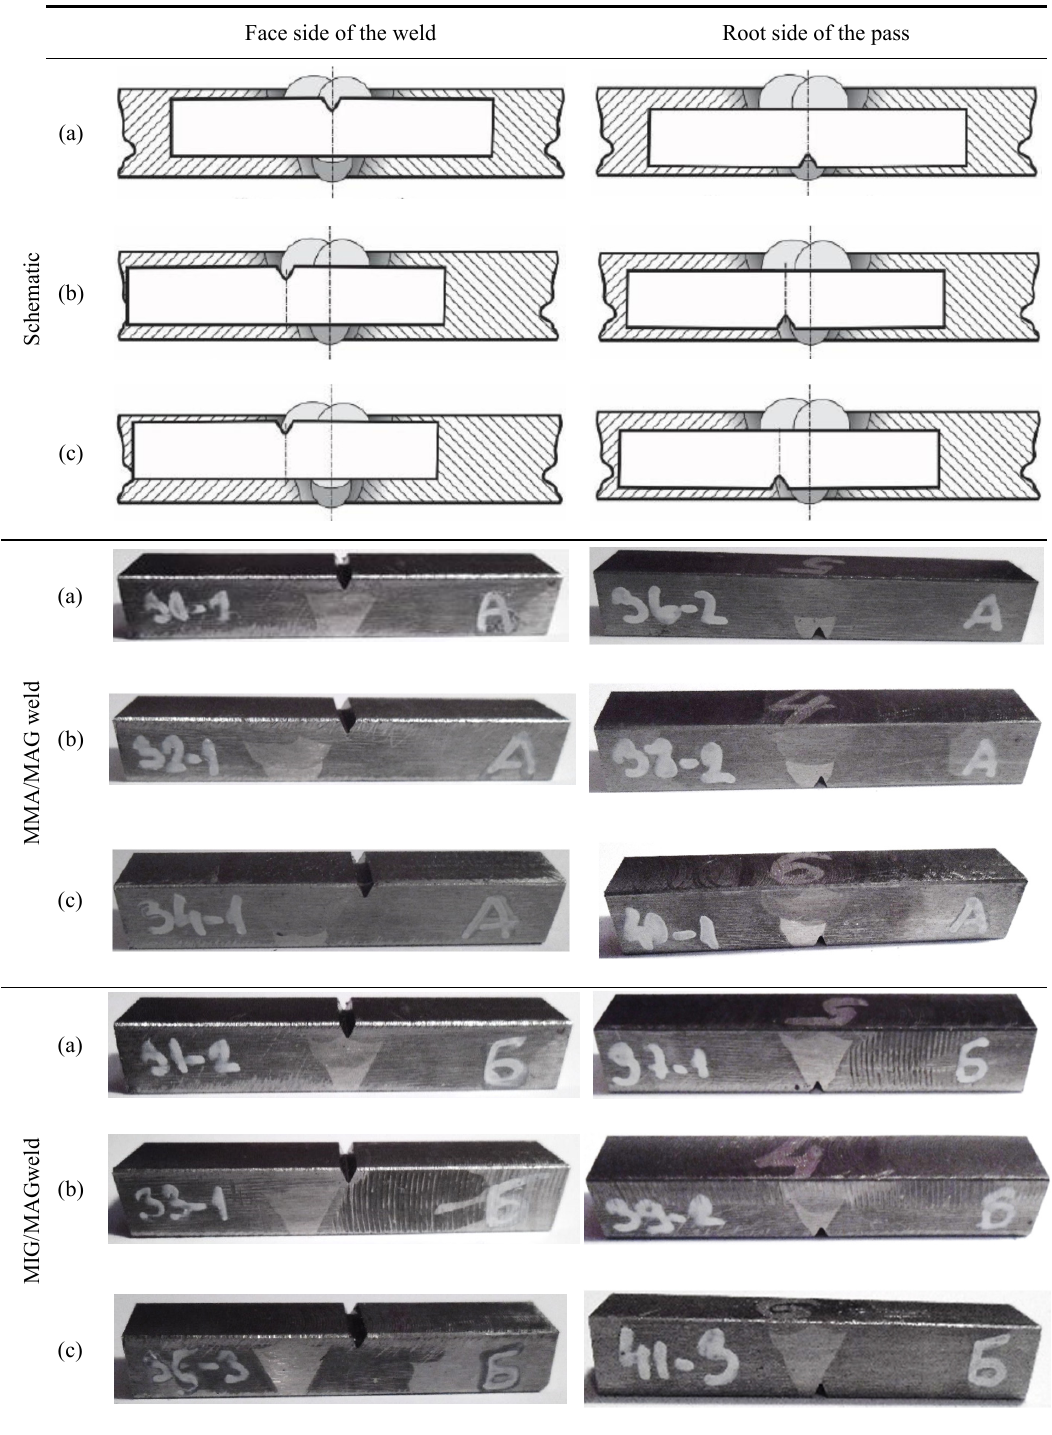
Figure 4. Position of the notch on samples for the impact toughness testing: ( a ) along the weld axis; ( b ) in the fusion zone; ( c ) in the HAZ.